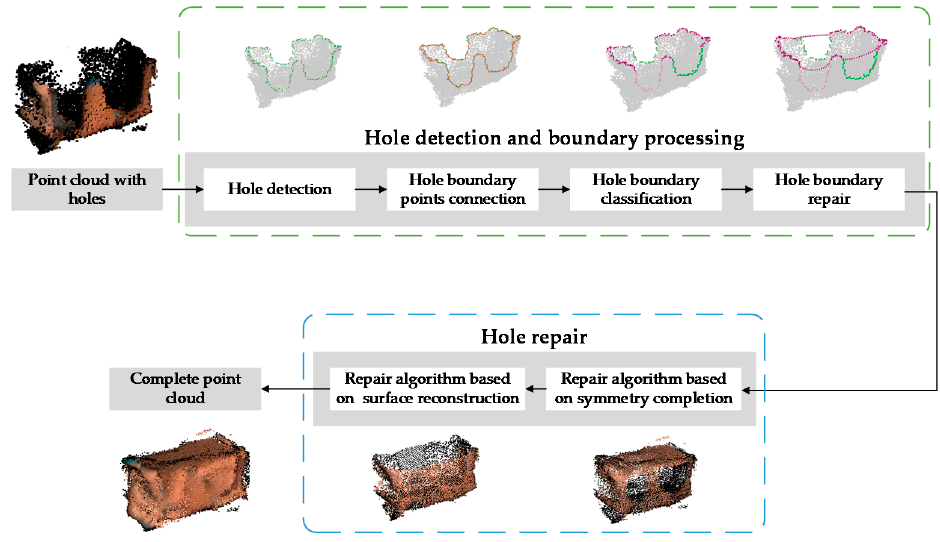
Figure 2. The flowchart of the proposed hole repair algorithm: the hole detection and boundary processing module and the hole repair module are included.